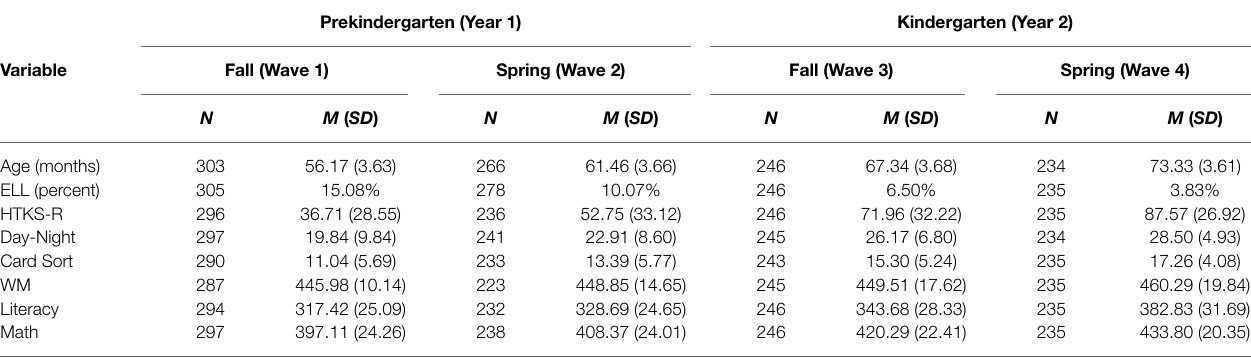
TABLE 1 | Descriptive statistics for all study variables.